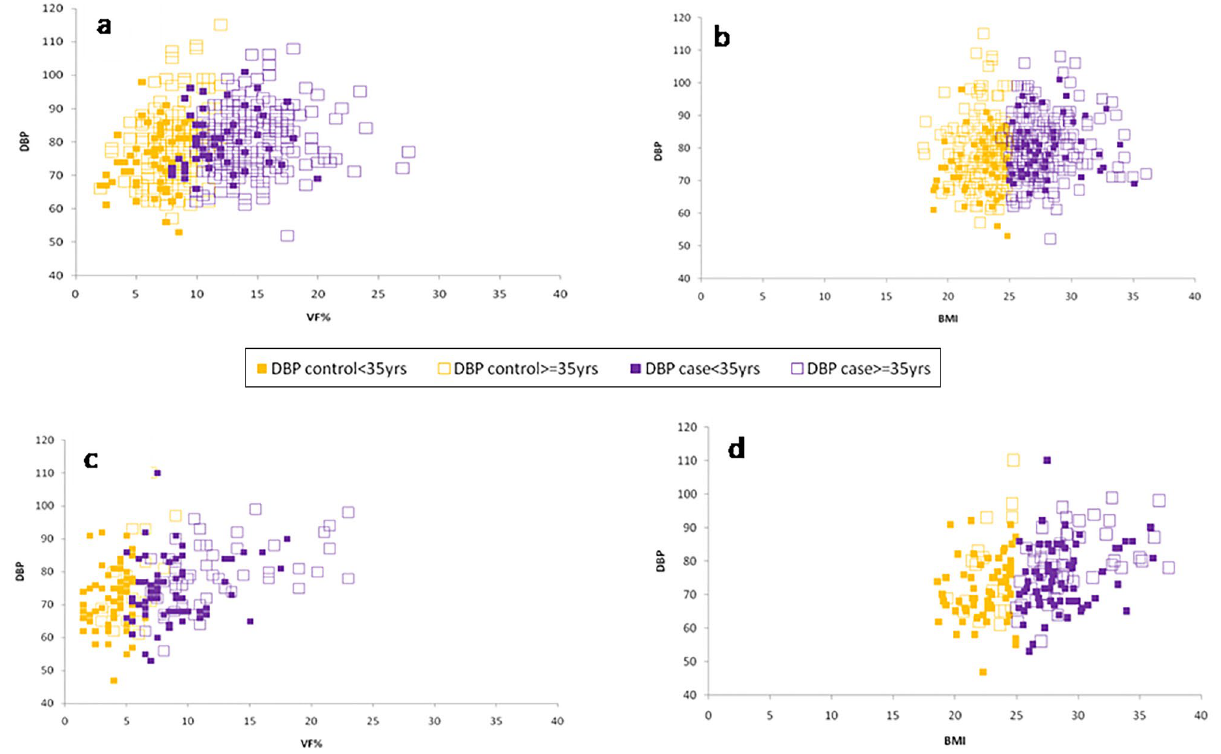
Figure 3. Association between (i) VF% and DBP ( a & c ) (ii) BMI and DBP ( b & d ) in the total male and female population respectively.